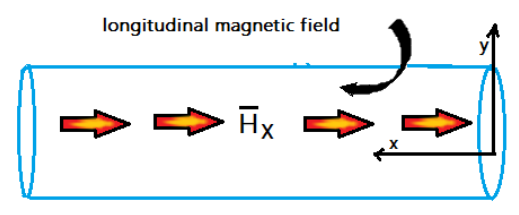
Figure 2: Single-walled carbon nanotube subjected to axial mag- netic